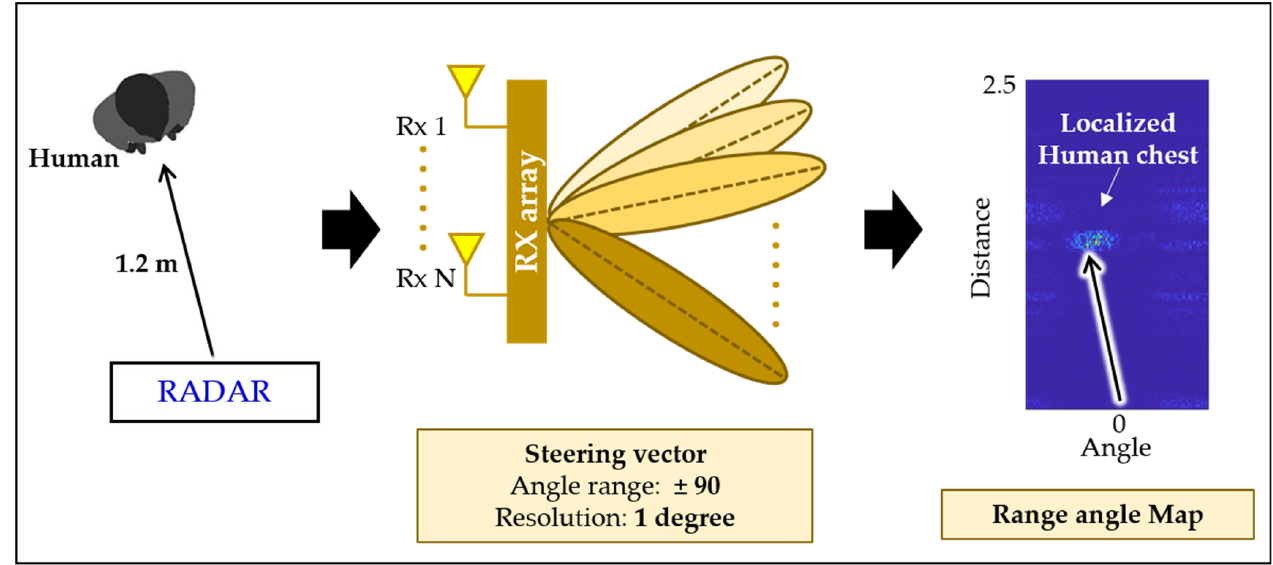
Figure 7. Target localization in the range–angle map using a beam steering vector.